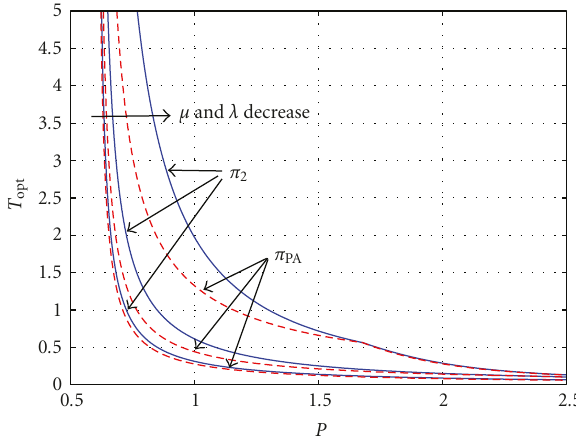
Figure 17: The optimal T opt under access policy π 2 and π PA